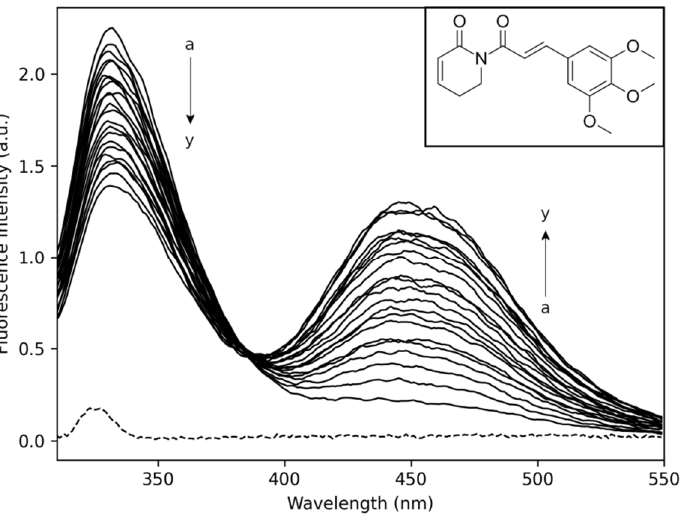
Figure 1. NBD fluorescence emission spectra obtained from titration experiments with increments in the concentration of PPL (pH 7.4, T = 283 K, λ excitation = 295 nm). [ NBD ] = 4.0 µ M; PPL titrations with increments of − 1.0 µ M (a → y = 0 µ M → 24 µ M). Inset: Chemical structure of PPL.